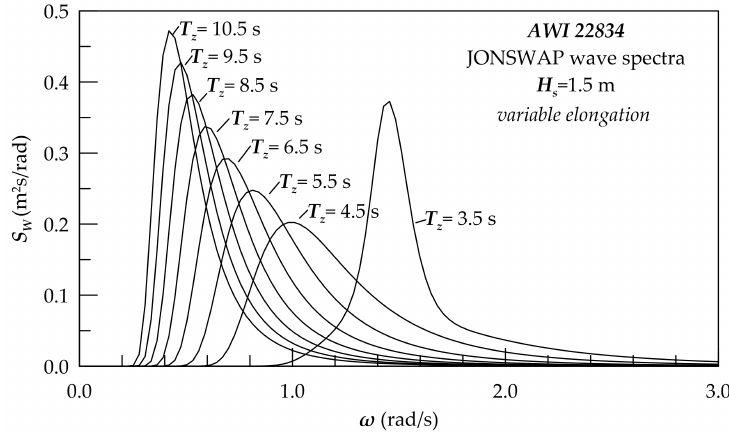
Figure 17. JONSWAP wave spectra for AWI environmental